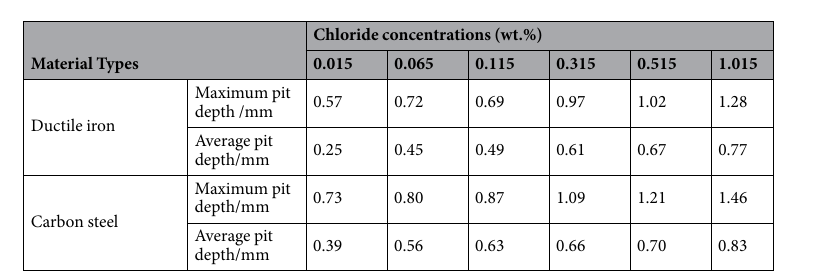
Chloride concentrations